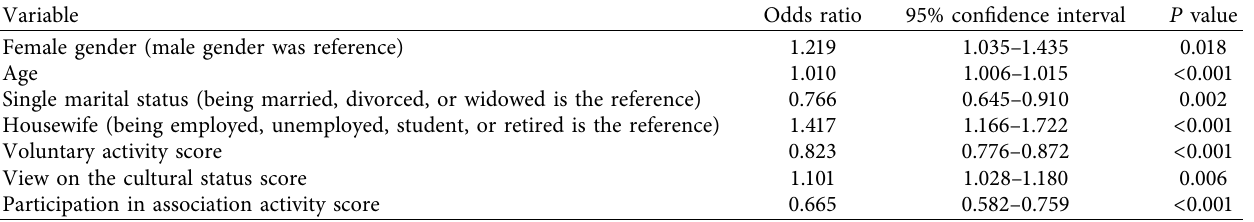
Table 4: Results of binary logistic regressions to determine the factors associated with physical inactivity.